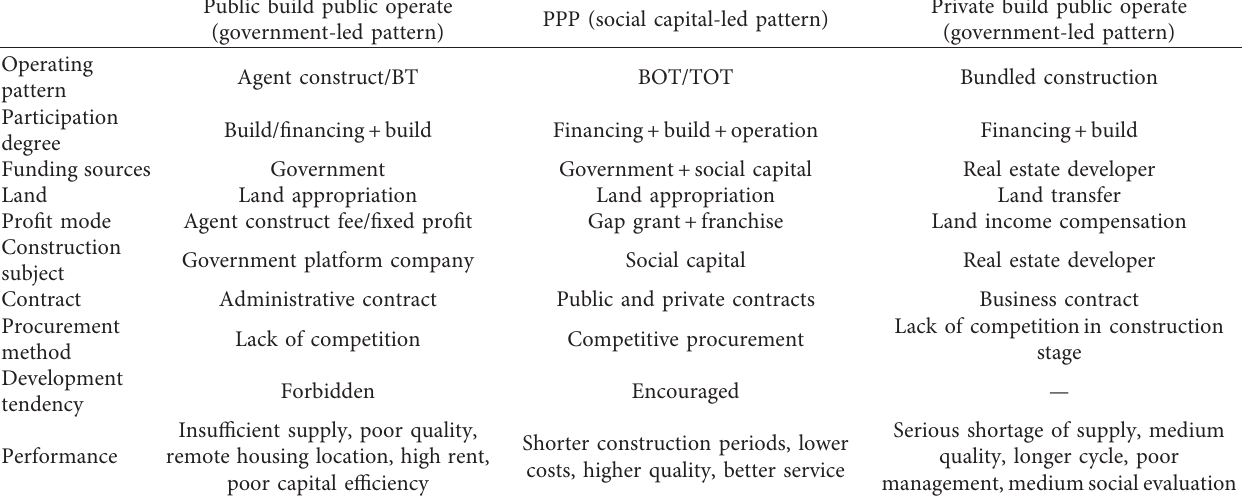
Table 1: Characteristics comparison of public rental housing supply patterns.